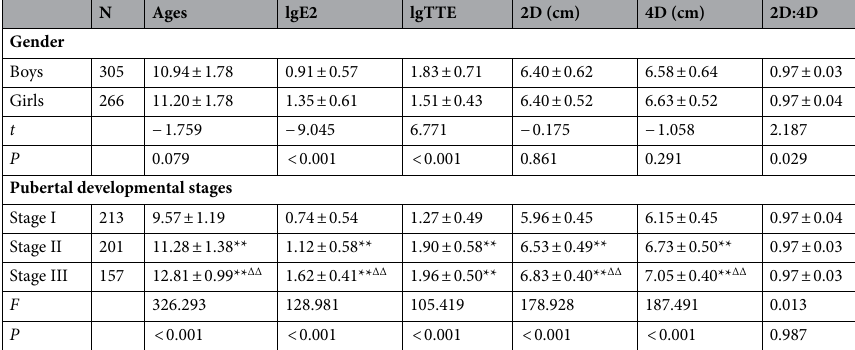
Table 1. The comparisons of 2D, 4D, 2D:4D, estradiol and testosterone in gender, puberty developmental stages. **Compared with the earlier stage P < 0.001; ΔΔ Compared with the early-mid stage P < 0.001.